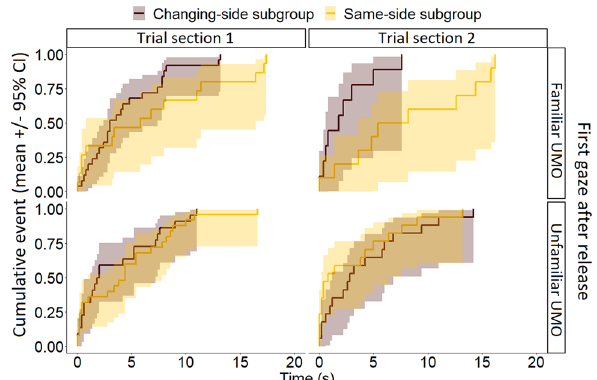
Figure 3. Significant three-way interaction on the latency of first gaze at a UMO after release in the Test phase. Shown are the combined effects of Location subgroup (Changing-/Same-side), First gaze (at familiar/unfamiliar UMO) and Trial section (first/second half of the Test